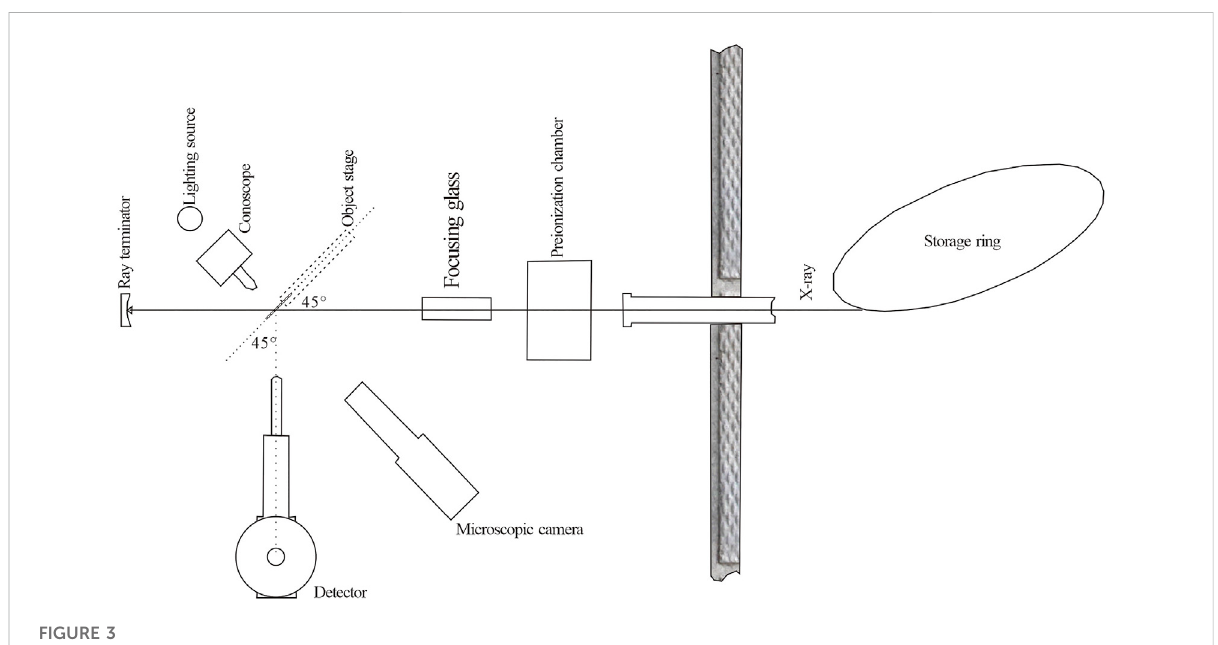
FIGURE 3 Schematic diagram of